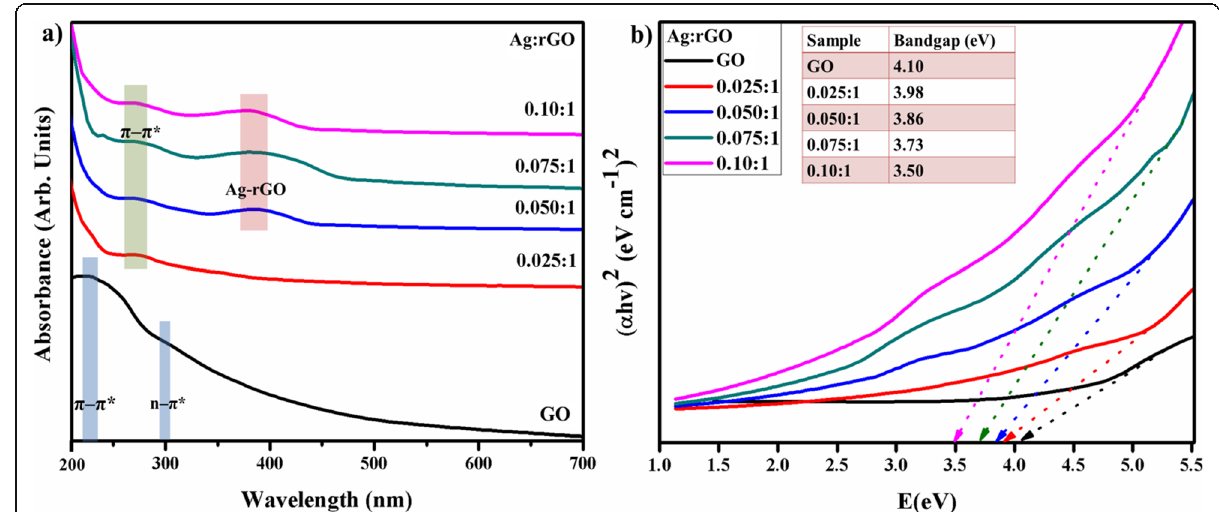
Fig. 4 a UV-Vis spectra of GO and Ag-rGO. b Bandgap comparison